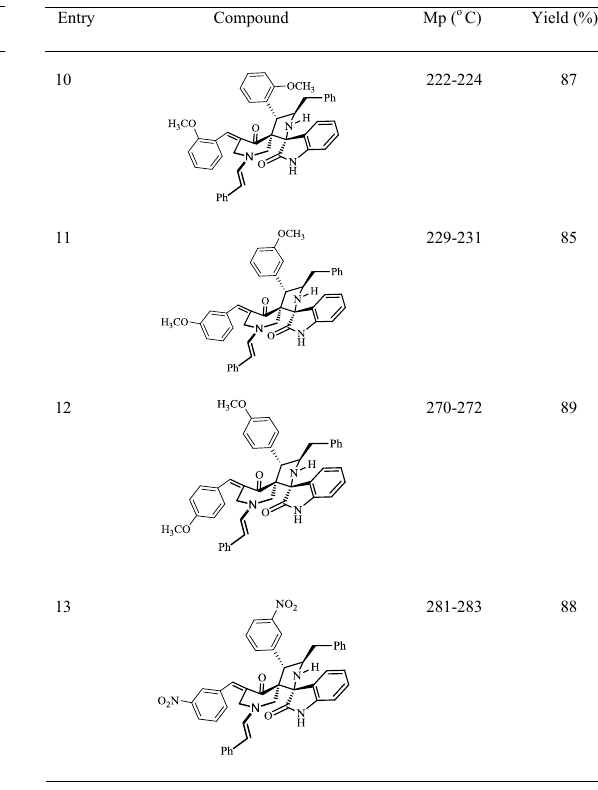
Table 2 Structures, yields and melting points of compounds 5a –